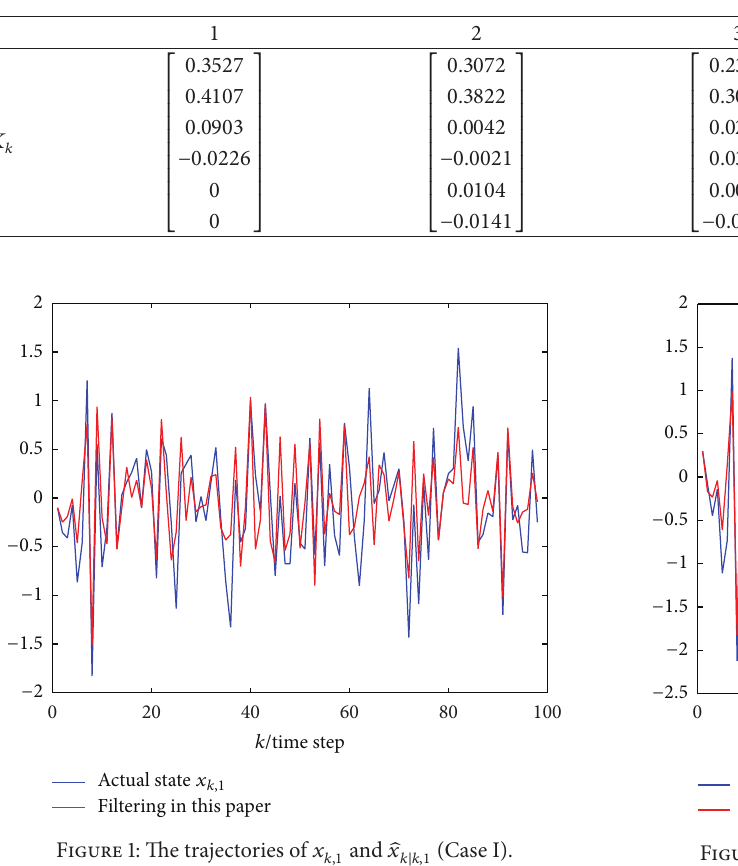
Table 1: Filter gains 𝐾 𝑘 (Case I).